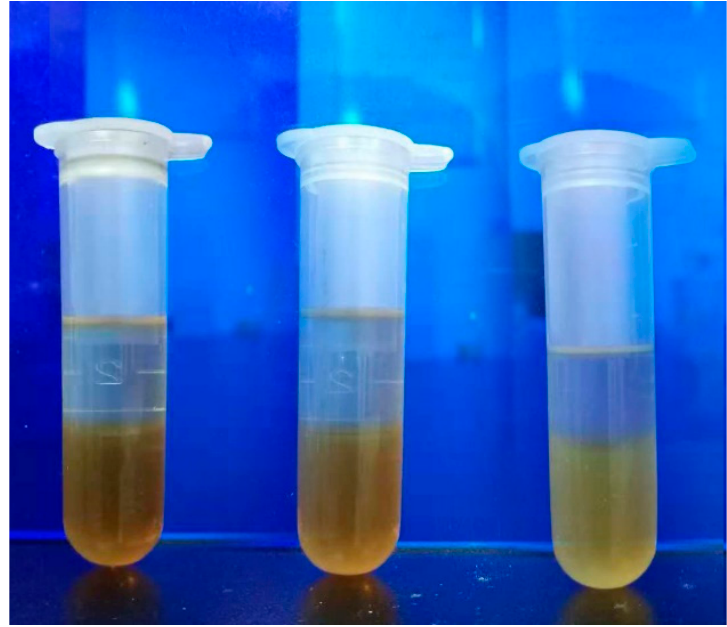
Figure 5. Residual liquid of 400 °C, 450 °C, and 500 °C (from left to right) extracted by dichloromethane .